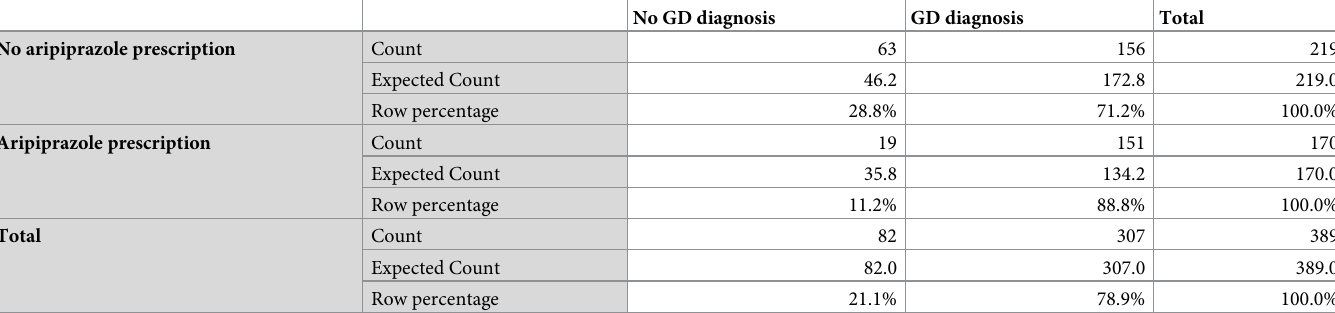
Table 2. Frequency counts and row percentages for aripiprazole prescriptions and GD diagnoses in patients with F20-29